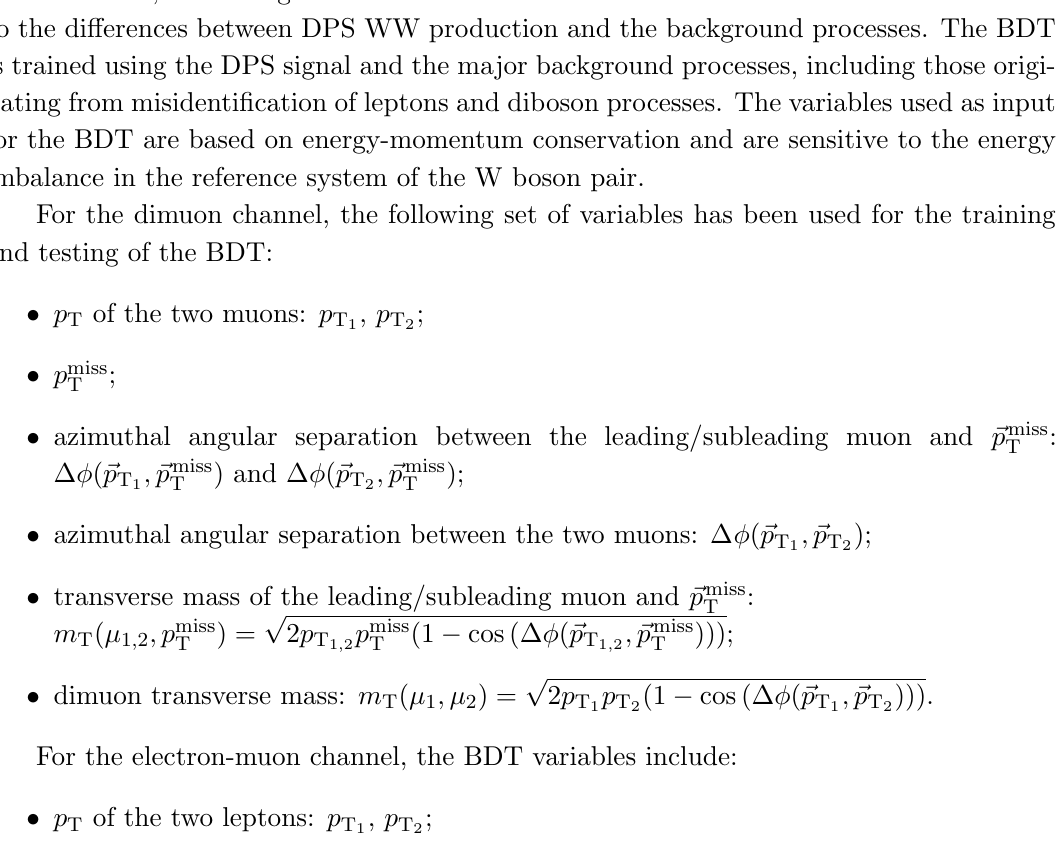
angular separation between the subleading lepton